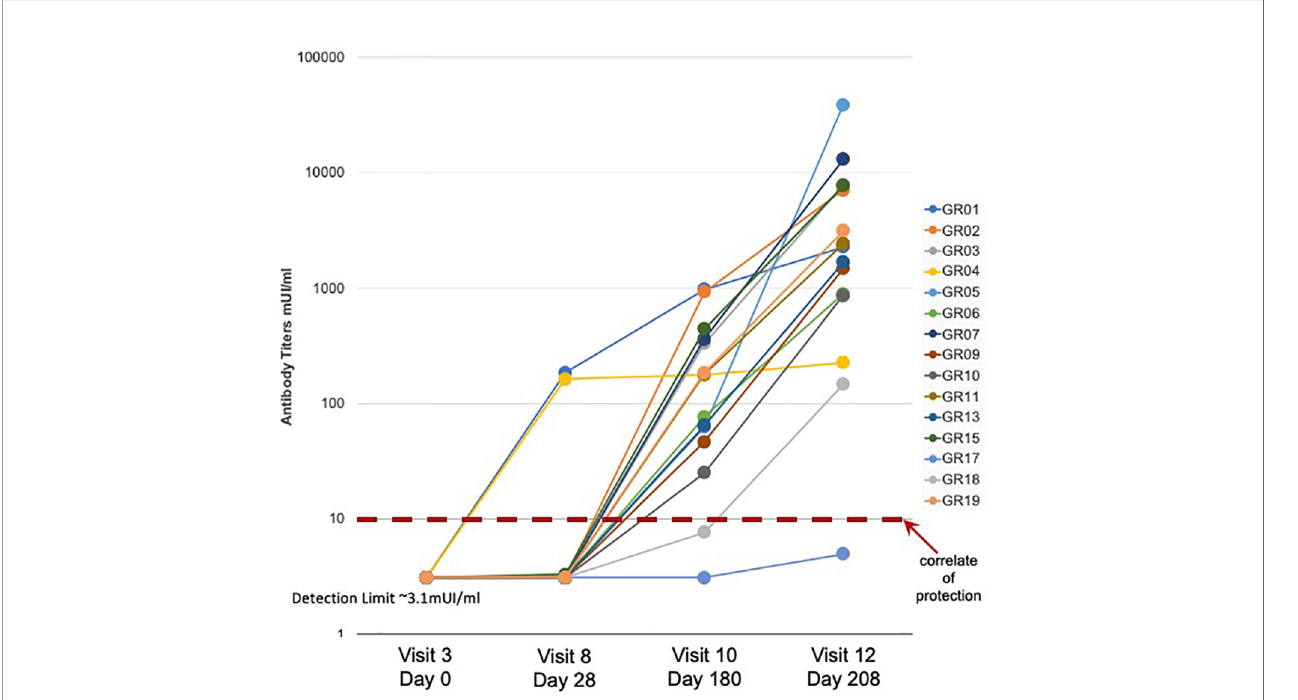
FIGURE 1 | Serum antibody response to HBV vaccination - Serum antibody titers were measured in samples collected from fi fteen study participants (GR01 – GR19) before (Visit 3) and after (Visit 8, 10, and 12) vaccination. Vaccine doses were administered on Visit 3, Visit 8 and Visit 10 (after blood collection) for a total of three doses of HBV vaccine in all fi fteen participants. Limit of detection of 3.1 mUI/ml and correlate of protection of 10 mUI/ml are indicated. These data were also previously used to create Figure 1C in